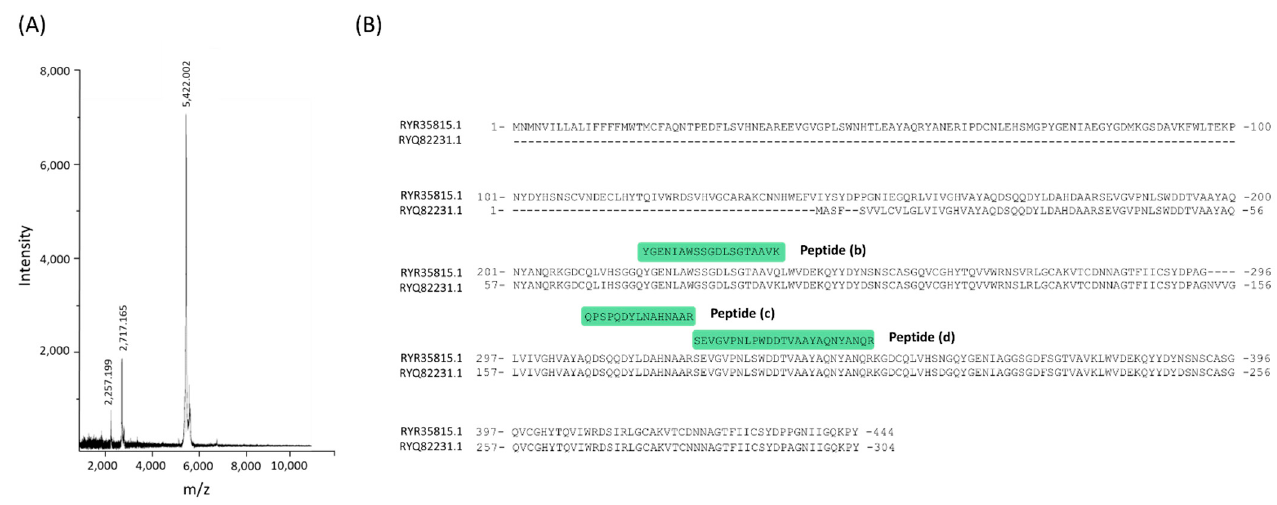
Figure 3. Peptide identification by MALDI-TOF mass spectrometric analysis. ( A ) MALDI-TOF-MS spectrum of GdAPs recorded in a linear positive mode (mass range from 0.9 to 10 kDa). ( B ) Sequence alignment of the tryptic peptides identified by MALDI-TOF MS/MS with the proteins RYR35815.1 and RYQ82231.1 encoded in the Arachis hypogaea genome.